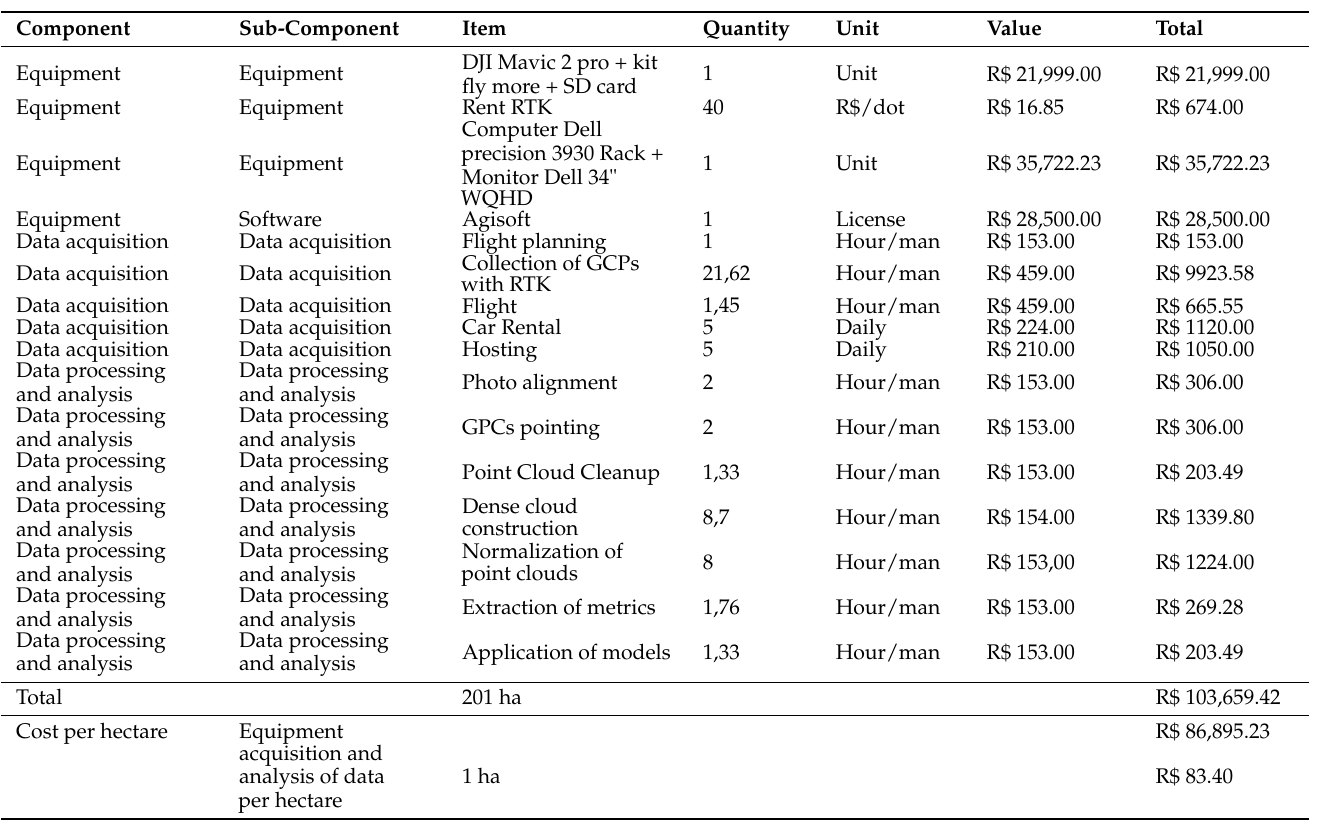
Table A3. Inventory cost components with